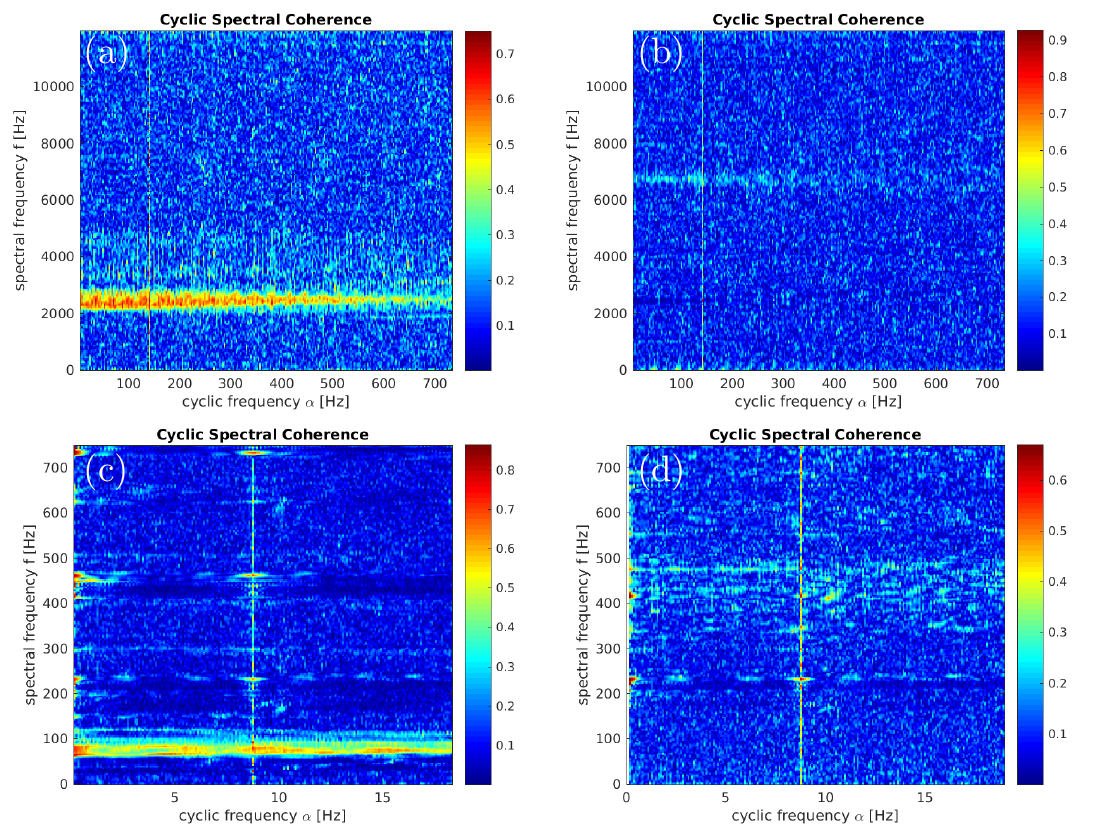
Figure 9. Cyclic Spectral Coherence of vibration signal recorded from planetary gearbox of wind turbine. From left to right the top row shows analysis on the original signal and its first IMF showing the gear-mesh of the planets. Similarly, the bottom row is the analysis of the same signal (down sampled) and its first IMF showing the BPFI of the bearing of the